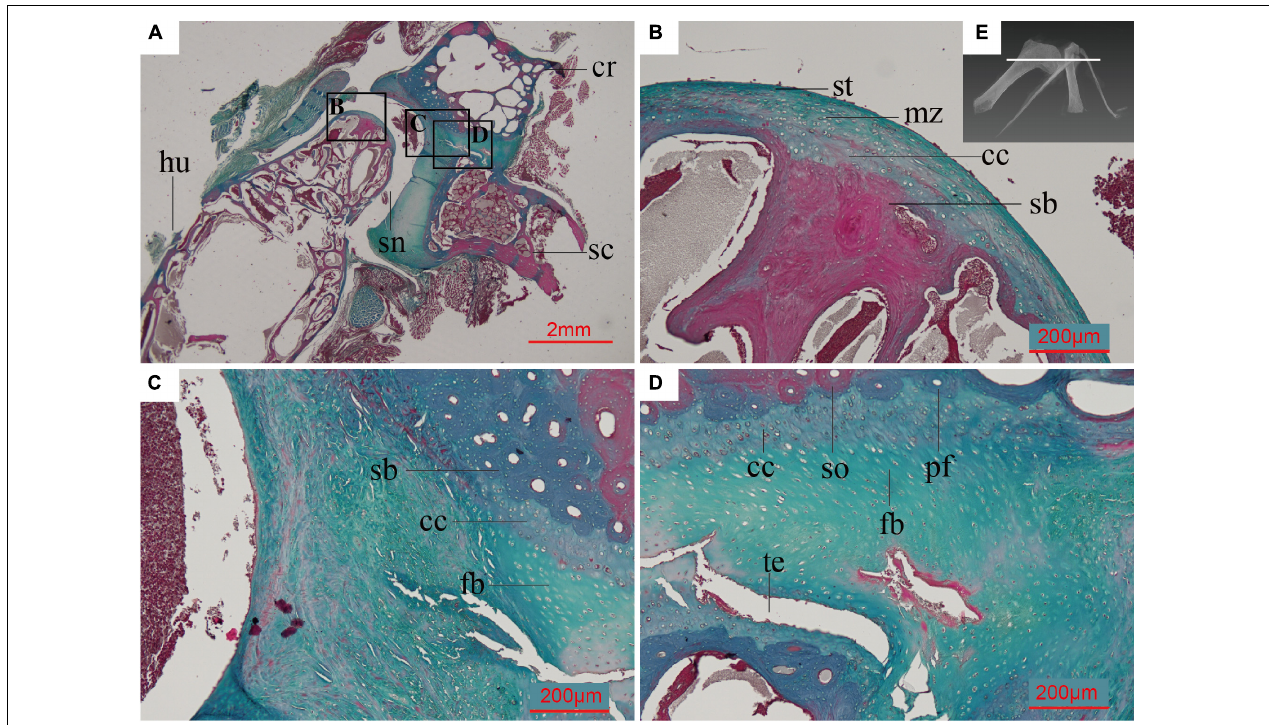
FIGURE 5 | Paraffin thin section showing the histology of the pectoral girdle of an adult Spilopelia chinensis (Spotted dove). (A) Thin-section of shoulder joint in Spotted dove, indicated by the white line in panel (E) . It shows a synovial joint between the humerus and the scapula and coracoid, the latter two technically “separated” and only linked together by some unmineralized fibrocartilage; (B) Close-up of left black box in panel (A) , showing the histology of the humeral head and its articular cartilage, with its multiple zones; (C) Close-up of middle black box in panel (A) ; (D) Close-up of right black box in panel (A) , showing the synchondrosis joint formed by fibrocartilage and calcified cartilage between the scapula and coracoid; (E) 3D reconstruction of shoulder joint of the Spotted dove. cc, calcified cartilage; cr, coracoid; fb, fibrocartilage; hu, humerus; md, middle zone; pfb, parallel-fibered bone; sb, subchondral bone; sc, scapula; sn, synovial cavity; so, secondary osteon; st, superficial tangential zone; te, tear. This slide was stained with a modified Masson’s trichrome.